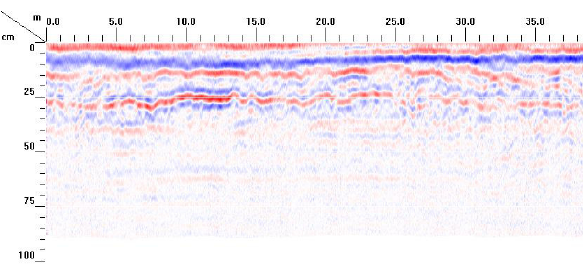
Figure 2. Visualization of a GPR